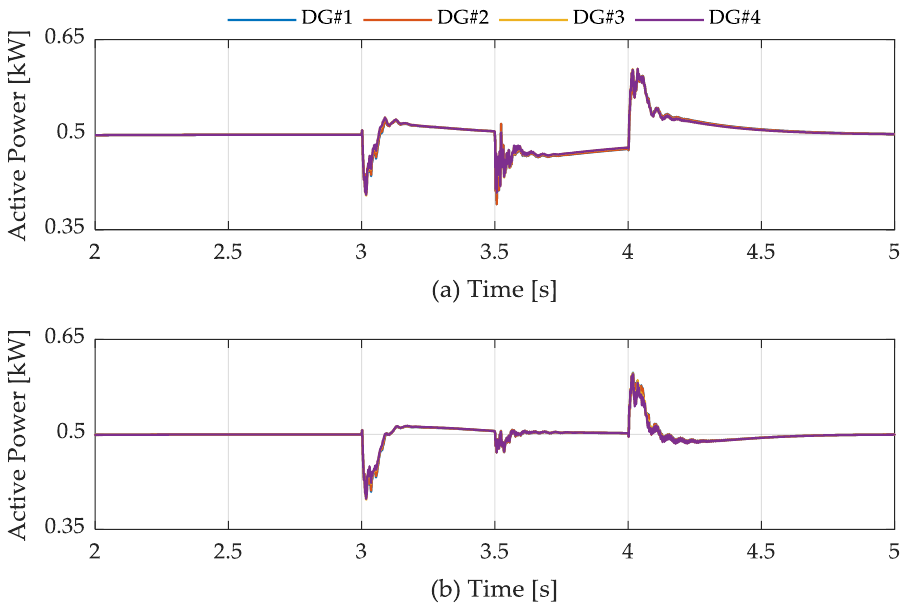
Figure 18. Output active power of each DG: ( a ) centralized method; ( b ) proposed method.